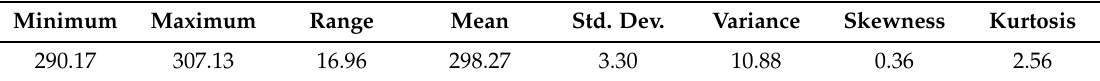
Figure A4. Histogram plot of the air outlet temperature measured using “Hobo” sensors, within the 7688 data sets collected by SRNL from F-Area cooling towers (unsaturated conditions). Table A3. Air outlet temperature distribution statistics [K], measured using “Hobo” sensors.